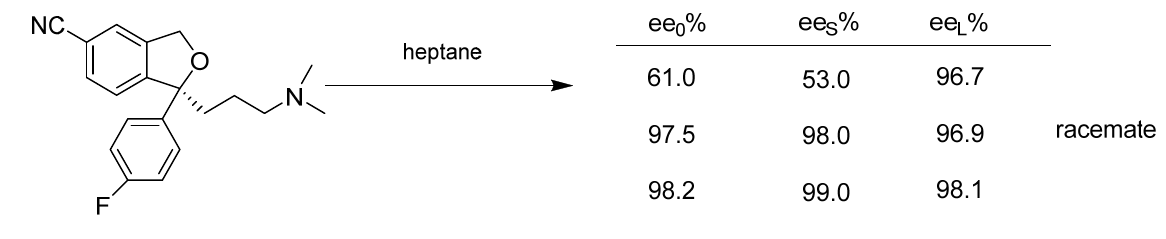
Figure 23. At the recrystallization of CTP , the racemic fraction of the enantiomeric mixture enters the solid phase already at 60% of ee 0 .